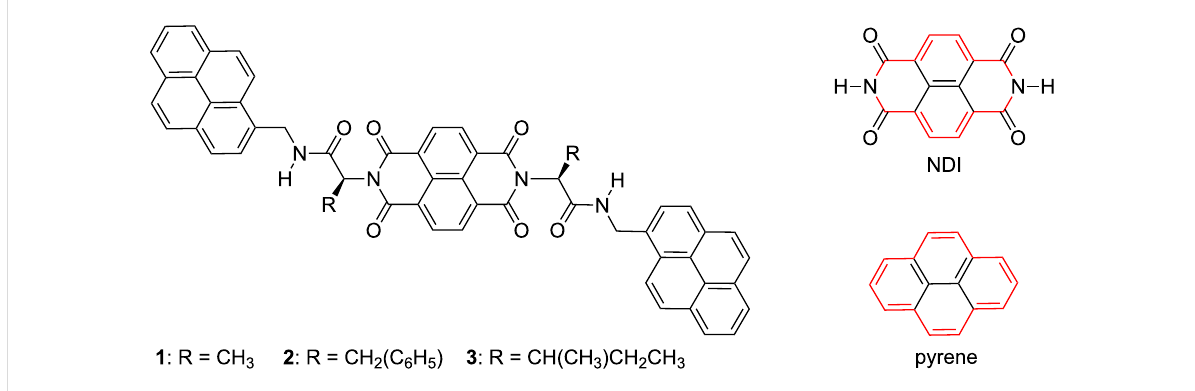
Figure 1: Molecular structures of donor–acceptor–donor traids. The red colouring highlights the topological symmetry of NDI and